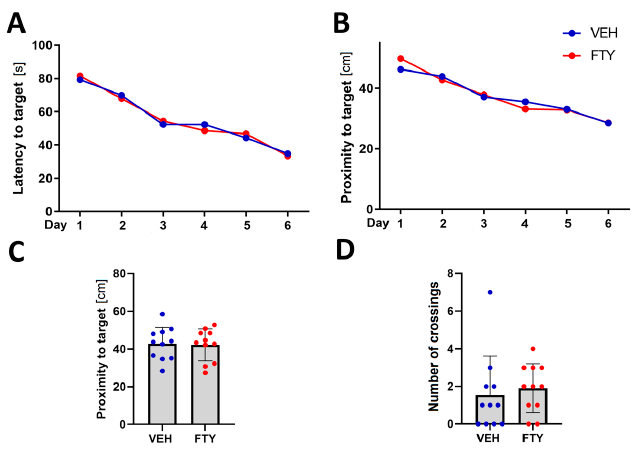
Figure A1. Assessment of the circadian activity during a 24 h period revealed no differences between VEH-treated (blue triangles) and FTY-treated (red triangles) males. Animals were treated according to the early treatment paradigm. ( A ) Mean hourly count of movements of animal groups (grey indicates dark hours; white indicates light hours of the day). ( B ) Relative distribution of the activity and ( C ) number of detected movements for each experimental group during light and dark hours. Significance in activity between treatment groups was calculated using the Student’s t -test. Data are presented as mean ± SD, VEH n = 11, FTY n = 12.